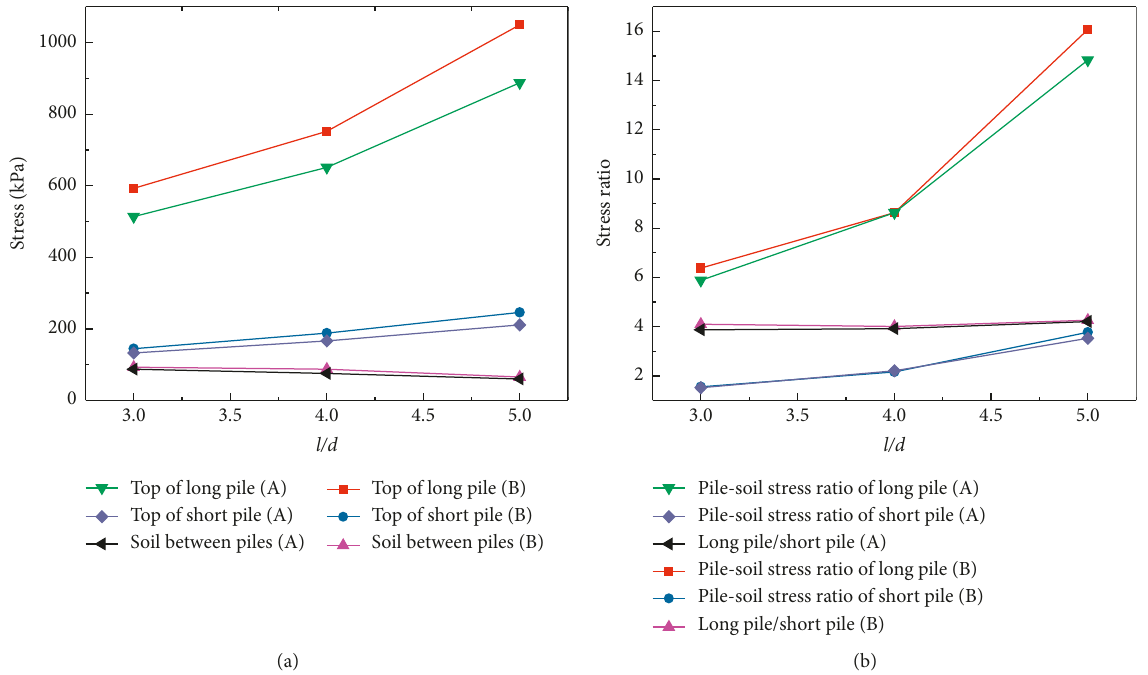
Figure 13: Effect of arrangement and pile spacing on bearing capacity of long-short pile composite foundation. (a) Stress. (b) Stress ratio.